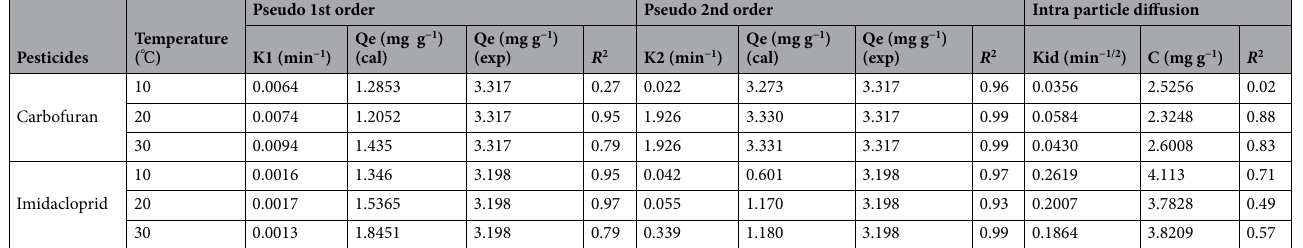
Table 4. Kinetic study for the adsorption of imidacloprid and carbofuran on silica anchored GO composite.